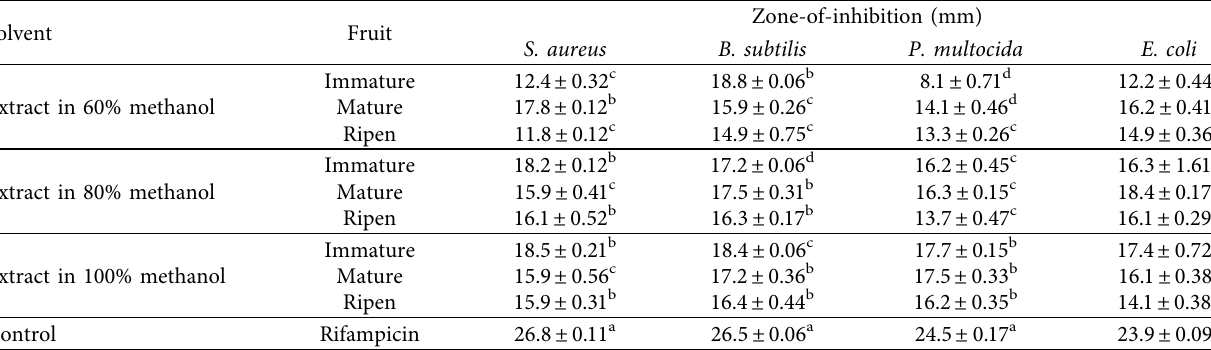
Table 2: Antibacterial activity of immature, mature, and ripen BG extracts in 60%, 80%, and 100% methanol using food-born and MDR bacterial strains.